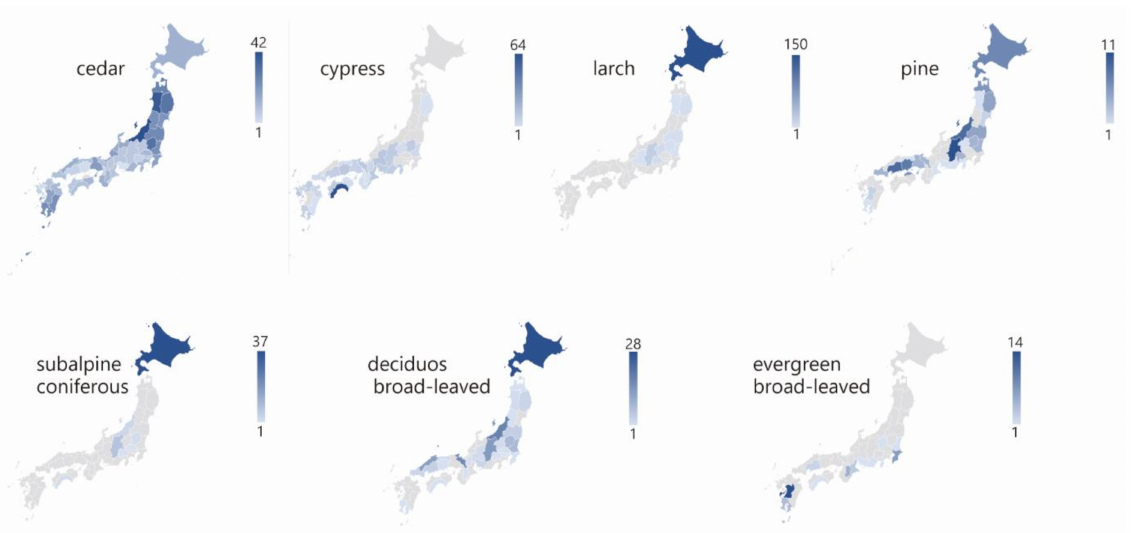
Figure 1. Distribution of the sample size of forest floor mass data in the prefecture level in Japan. Nutrient storage data are shown in Table S1.